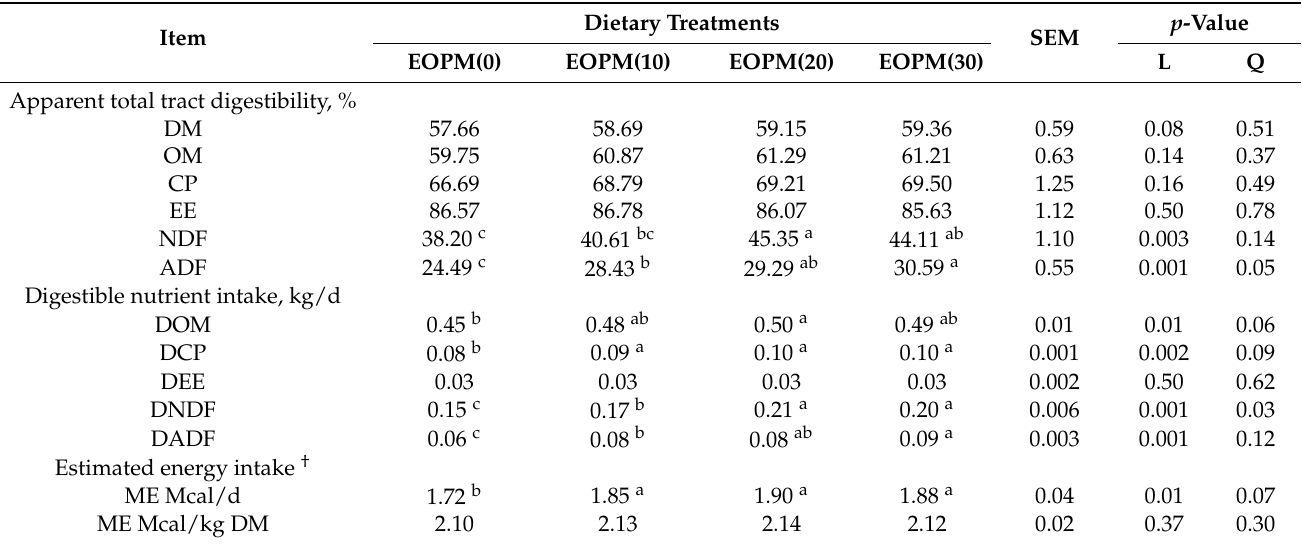
Table 3. Nutrient digestibility and digestible nutrient intake of goats fed TMR diets containing extracted oil palm meal